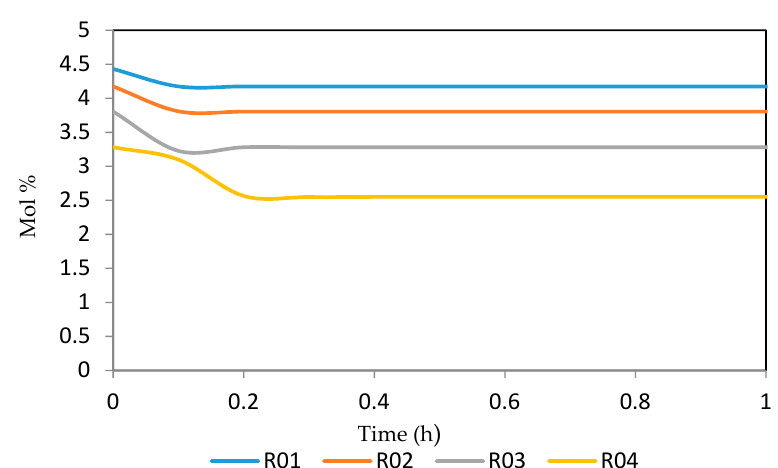
Figure 19. Dynamic behaviour of P 9 in the four reactors.